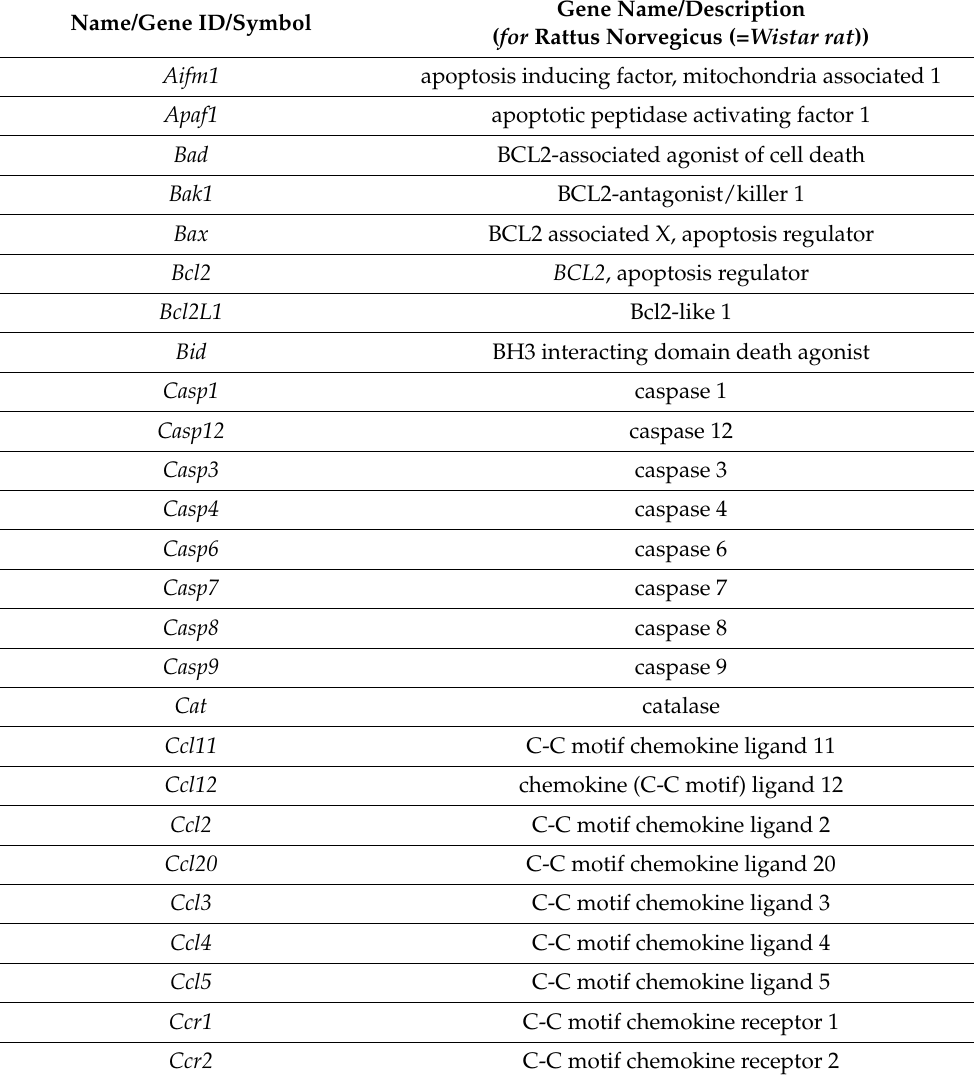
Table 3. Gene symbol and